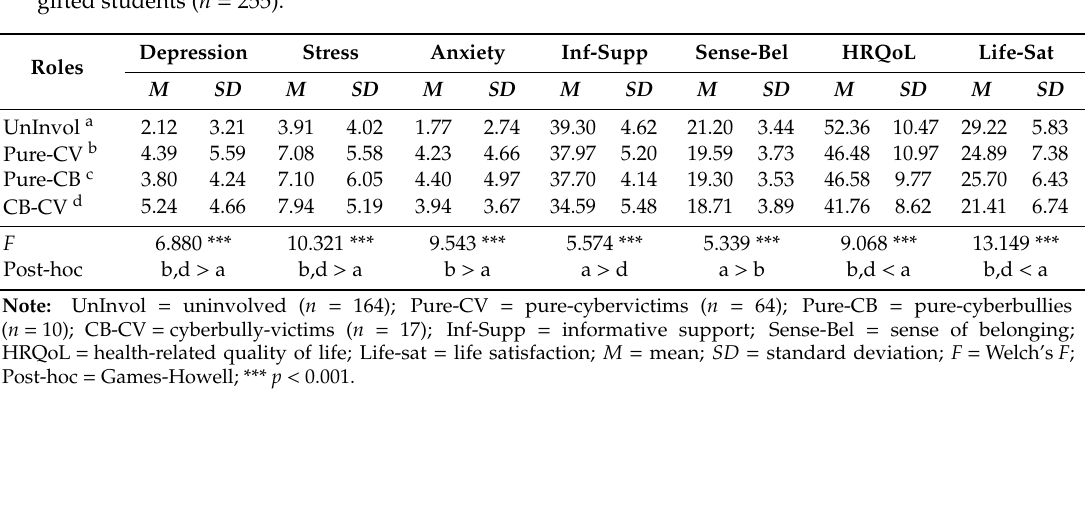
Table 4. Comparisons of the total scores in the depression, anxiety, and stress scale, informative support and a sense of belonging, HRQoL, and life satisfaction based on cyberbullying roles performed by gifted students ( n =